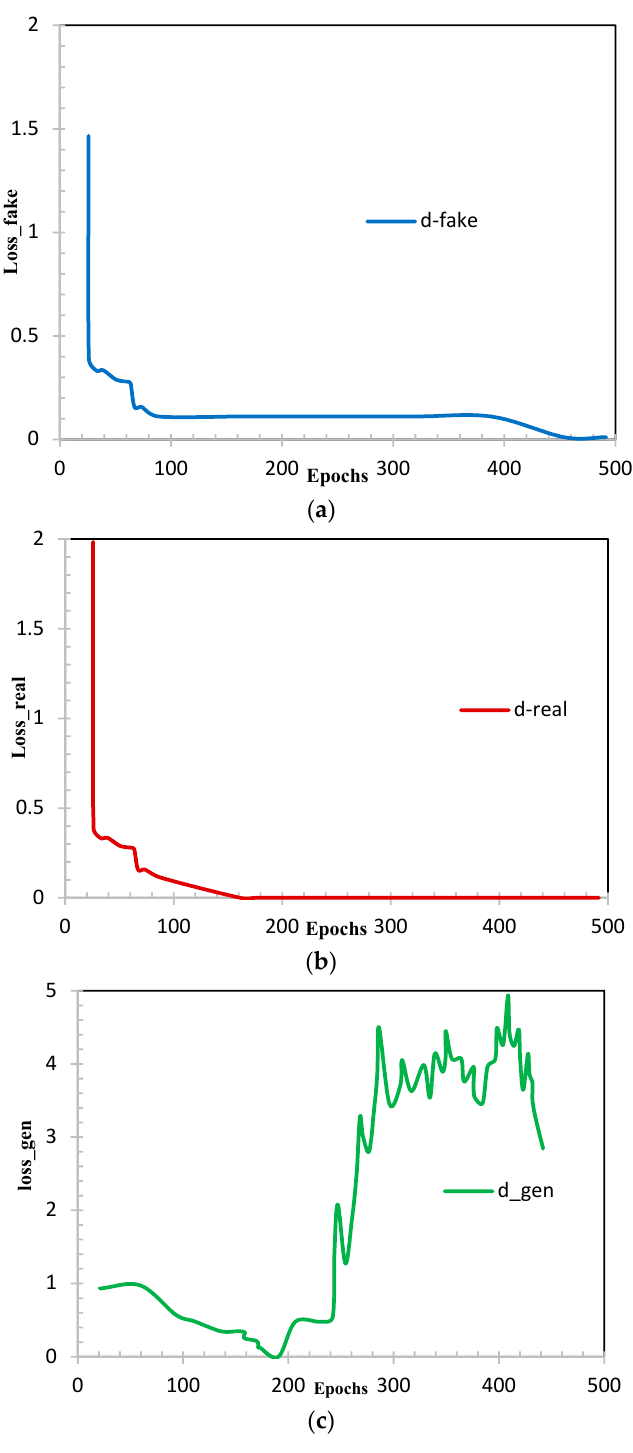
Figure 9. Loss of ( a ) fake samples; ( b ) real samples and ( c ) generator.